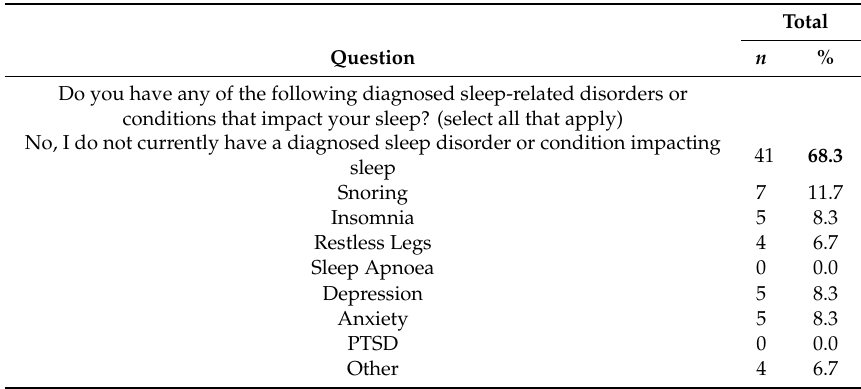
Table 2. Sleep quality and quantity of